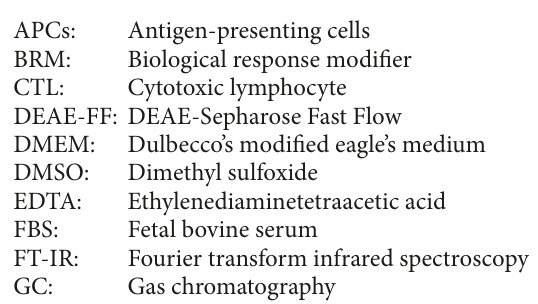
needs to be further examined for its potential functions to be